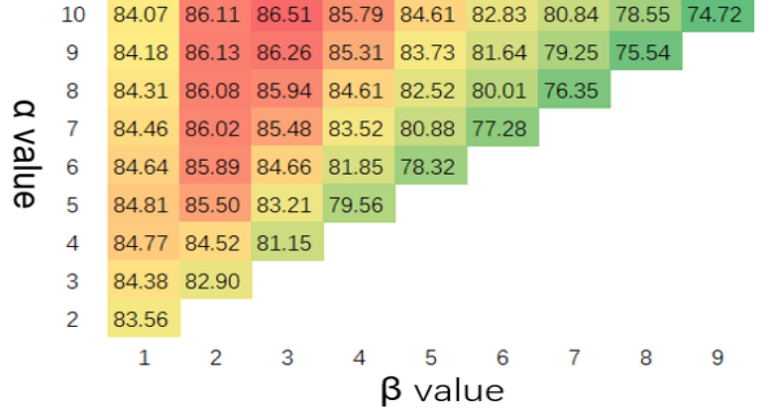
Figure 7. F1 score(%) with different values of α and β (scanning period = 128 and channel width = 20).